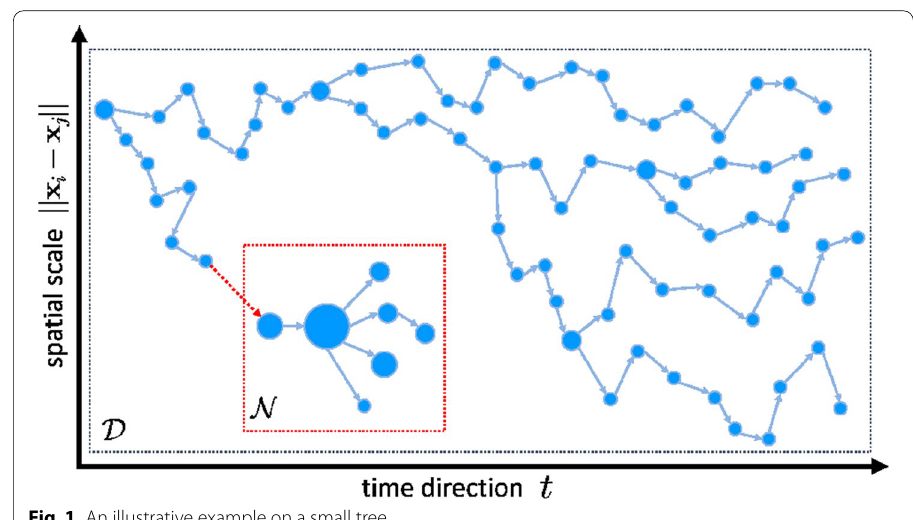
Fig. 1 An illustrative example on a small